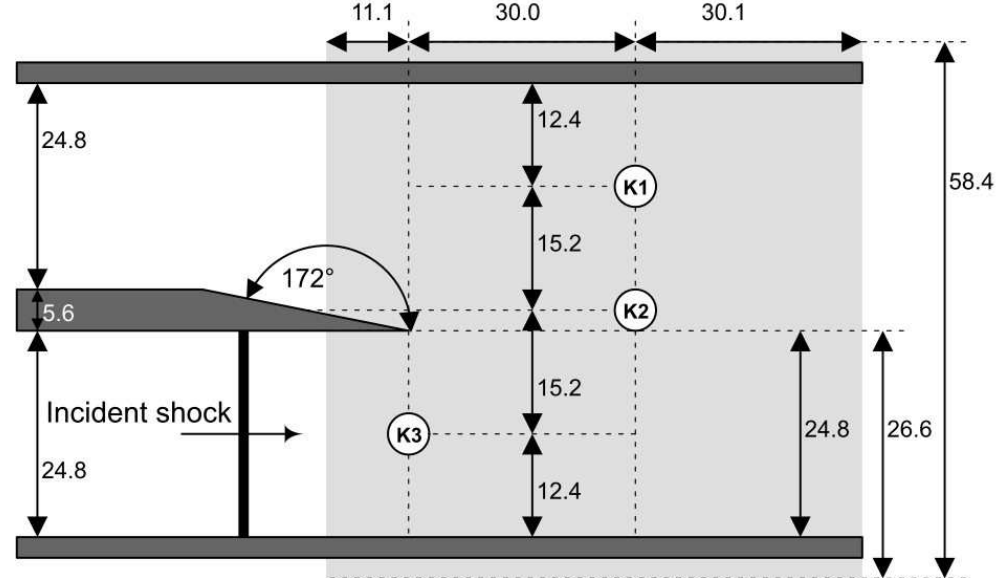
Figure 4. Test section geometry (all dimensions in mm).